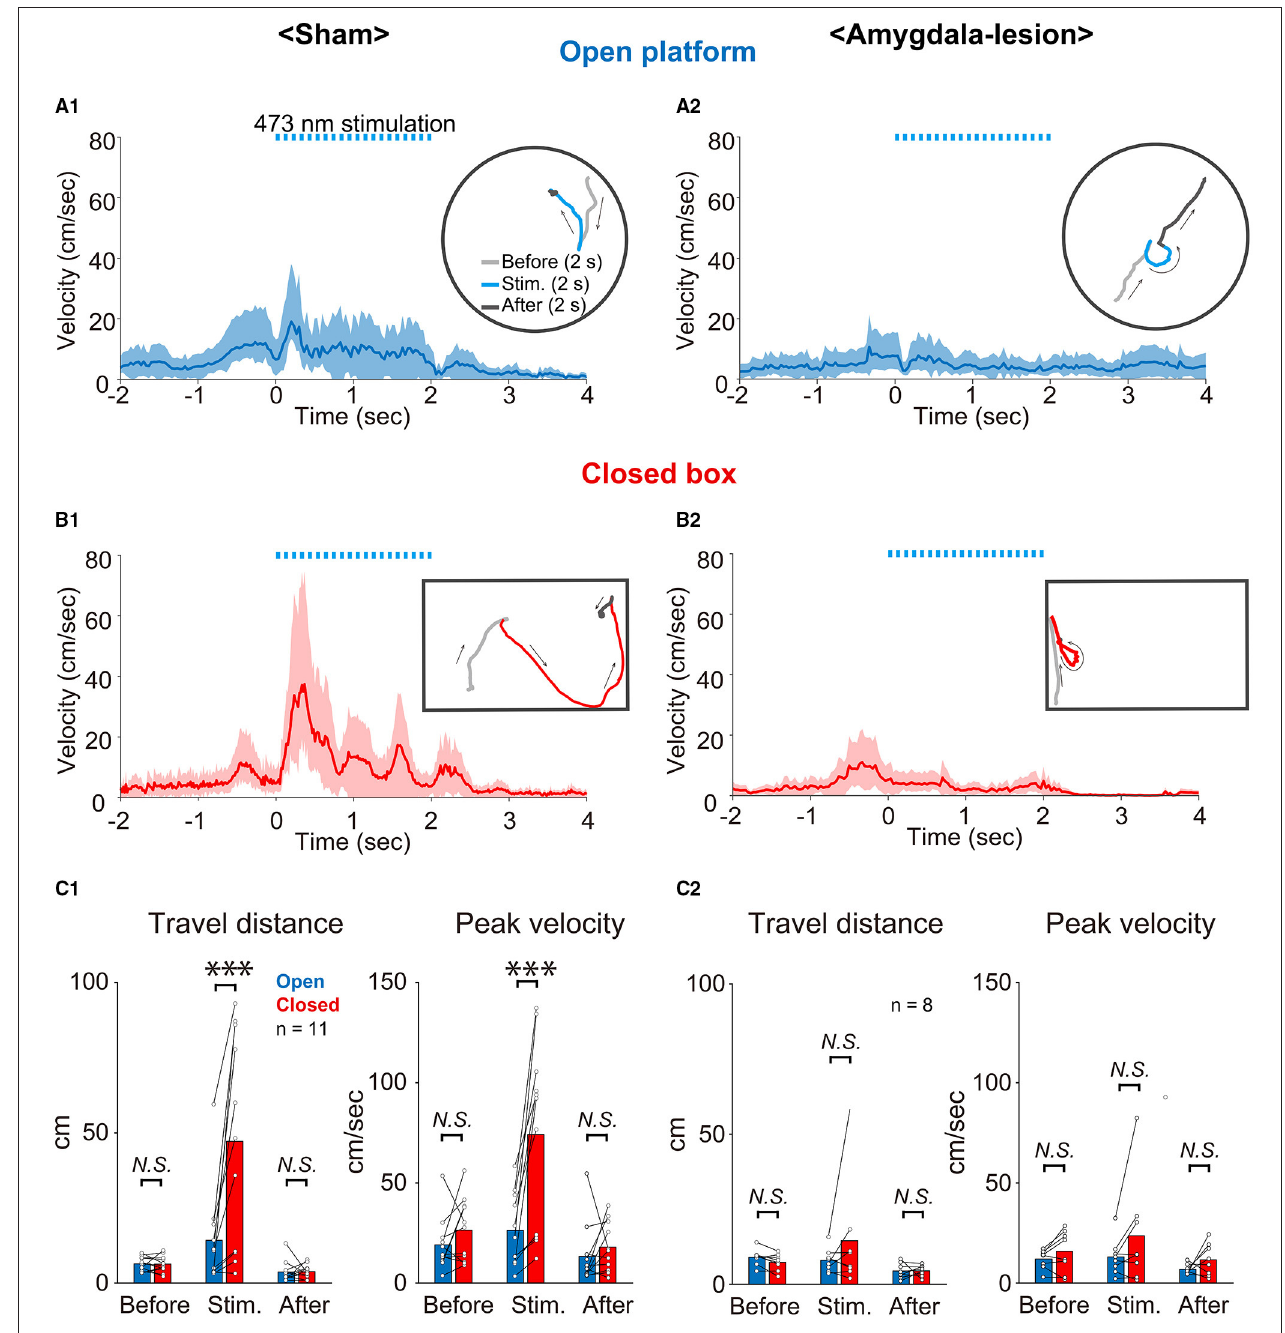
FIGURE 4 | Analysis of behavioral responses. (A,B) Averaged time course of locomotion speed and its trajectory (inset) of an example mouse on the open platform (A1,A2) and in the closed box (B1,B2) ( n = 10 trials in each) of sham-lesioned (A1,B1) and amygdala-lesioned (A2,B2) mice. The shaded area indicates the standard deviation of the averaged data. Dashed light-blue lines indicate 473nm photostimulation (20 trains of 50ms pulses at 10Hz). (C1,C2) Quantitative analysis of travel distance and peak velocity before (2s), during (2s), and after (2s) optogenetic activation on the open platform and in the closed box of sham-lesioned mice (C1) ( n = 11 mice; ***: p < 0.001, N.S.: p > 0.05, Bonferroni’s multiple comparison test) and amygdala-lesioned mice (C2) ( n = 8; N.S. : p > 0.05, Bonferroni’s multiple comparison